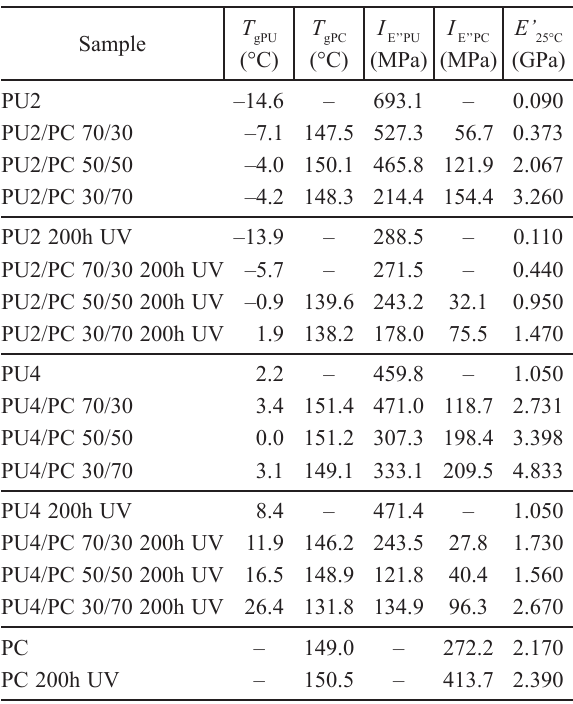
Table 3 – DMA results before and after UV irradiation